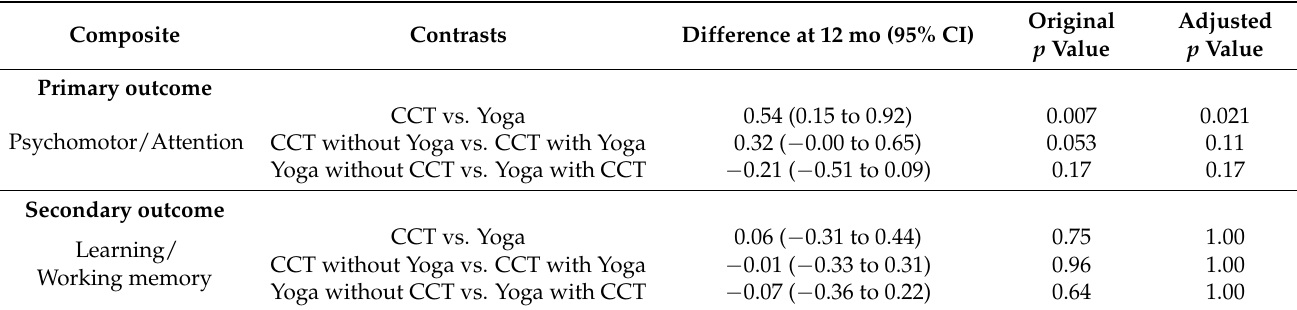
Table 3. Impact of CCT and yoga on patient cognitive composite scores at 12 months post-intervention outcome.